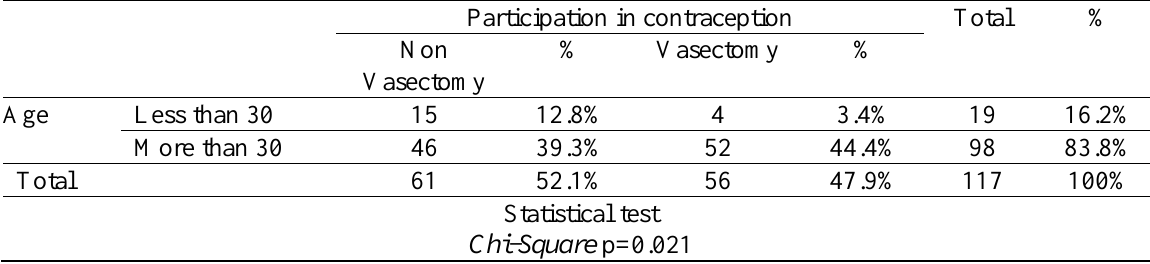
Table 4 The correlation of age with vasectomy selection